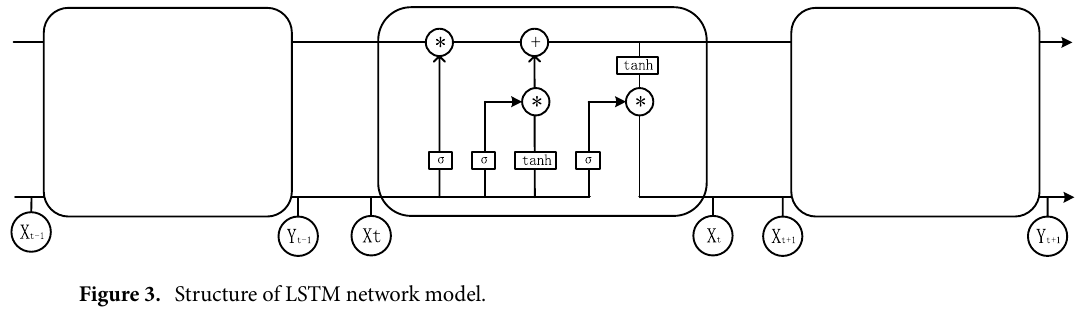
Figure 3. Structure of LSTM network